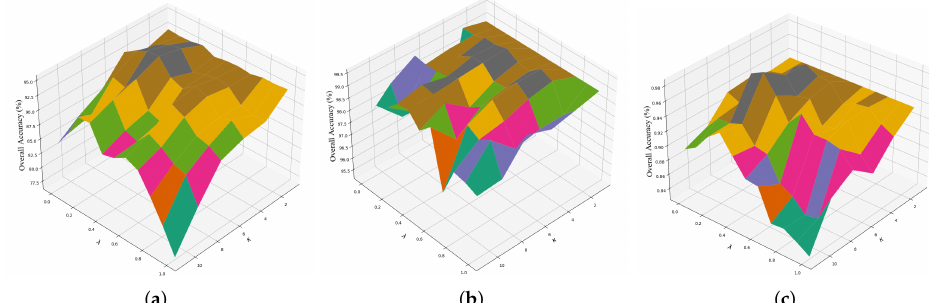
Figure 10. Influence of two parameters on classification accuracy on the three HSI data sets. ( a ) Indian Pines. ( b ) Salinas. ( c ) University of Pavia. λ is the spatial–spectral balance parameter, which determines the selection of the optimal reference scale (ORS). κ is the fusion threshold parameter, which determines the number of the multiscale maps. Deeper colors represent better